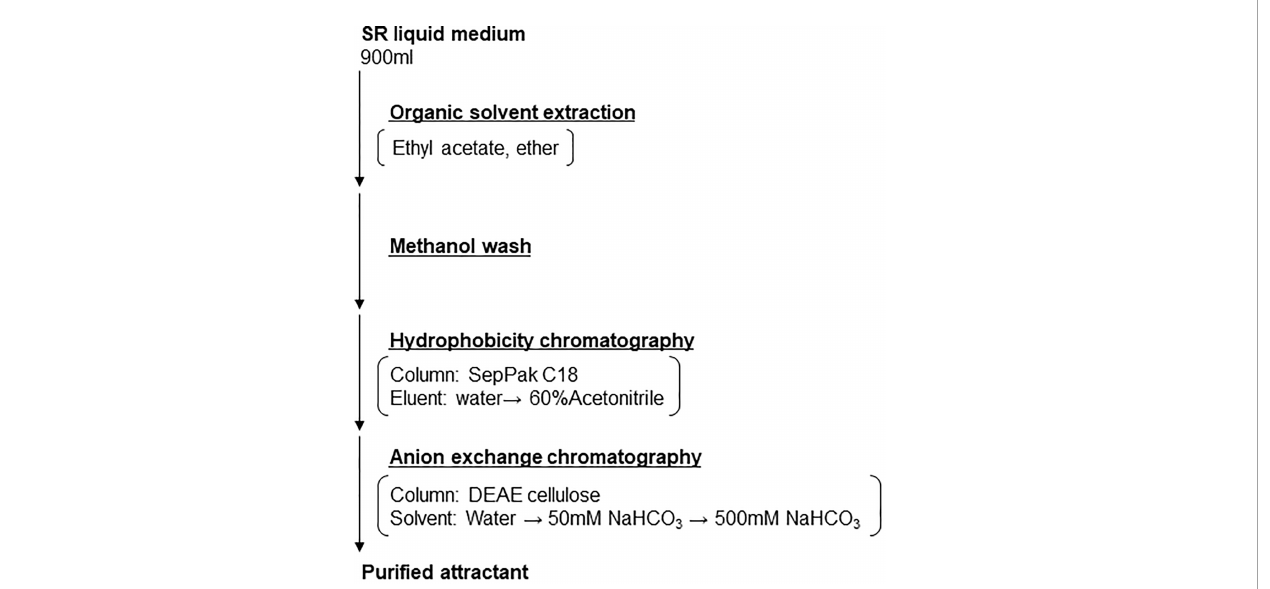
FIGURE 2 SR-secreted RKN attractant puri fi cation strategy. Schematic depicting the puri fi cation strategy to enrich and purify the RKN-attracting compounds from SR media supernatant.